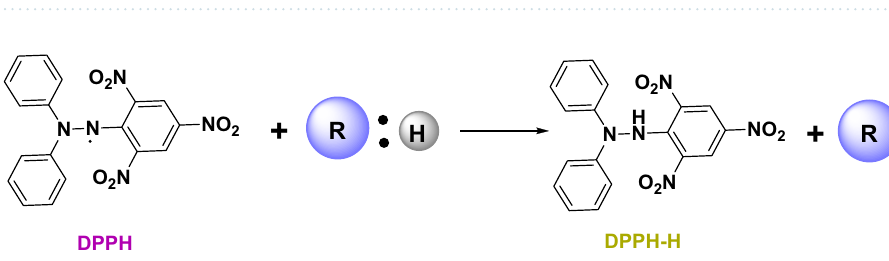
Figure 8. Mechanism of 2,2-diphenyl-1-picrylhydrazyl (DPPH) reaction with antioxidant, where R: H is aradical scavenger; R. is a radical